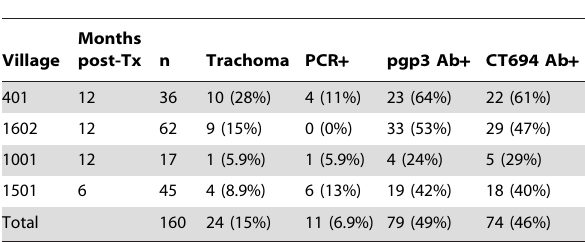
Table 1. Markers by